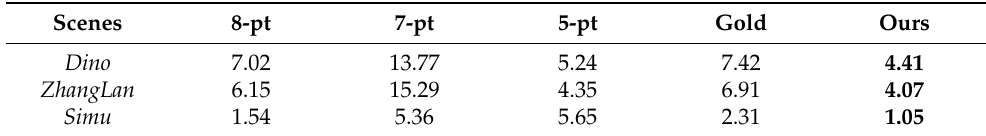
Table 2. Error comparison based on the average re-projection error from feature pixels u , u (cid:48) to P E X , P (cid:48) X . It shows that our method outperform other methods. E Scenes 8-pt 7-pt Dino